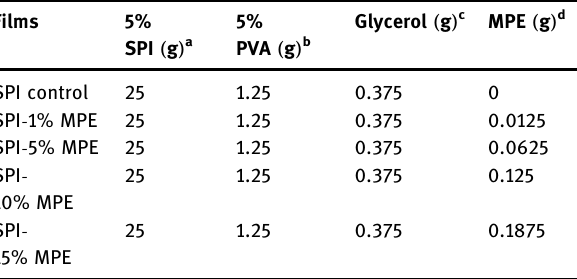
Table 1: Experimental formulations of the SPI fi lms with and without MPE Films